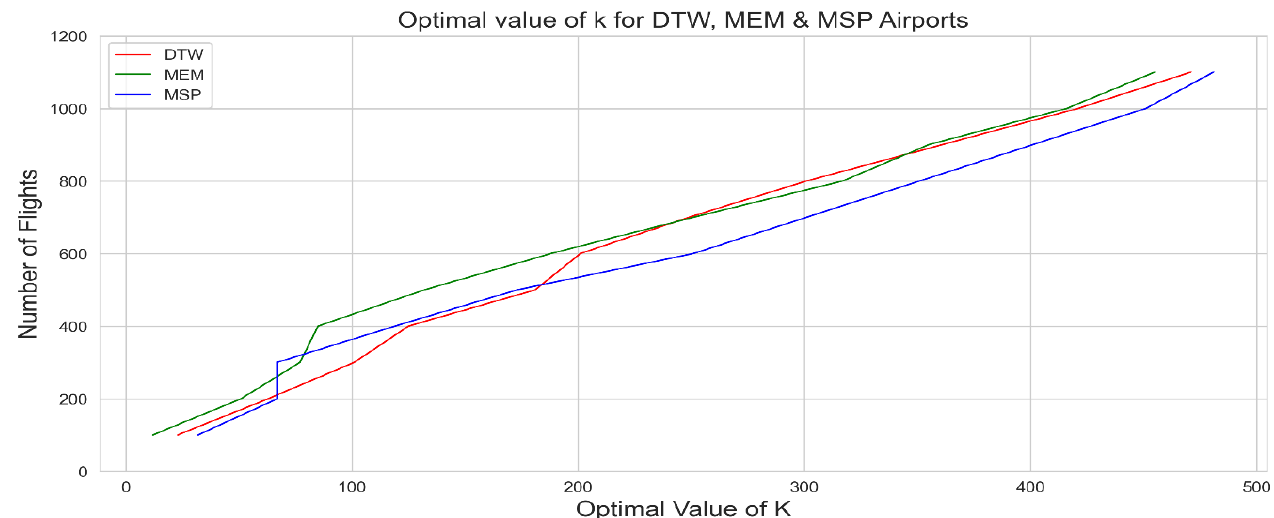
Figure 6. Maximum LOF scores across all flights at Minneapolis airport for different k values.